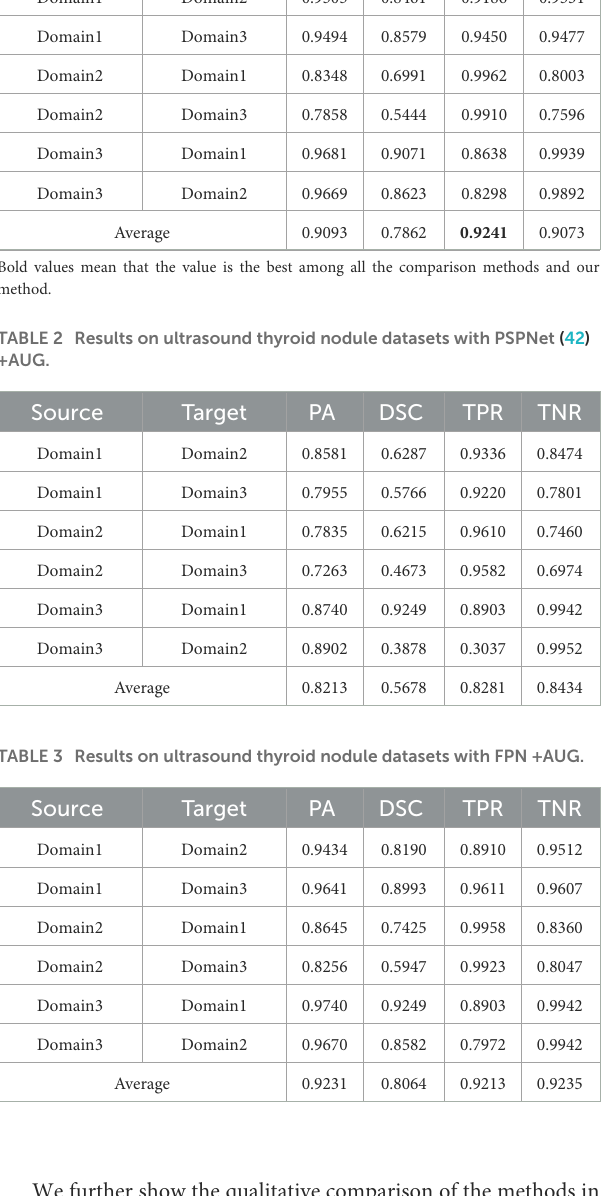
disabling consistency loss during training; (d) w/o DA: only segmentation